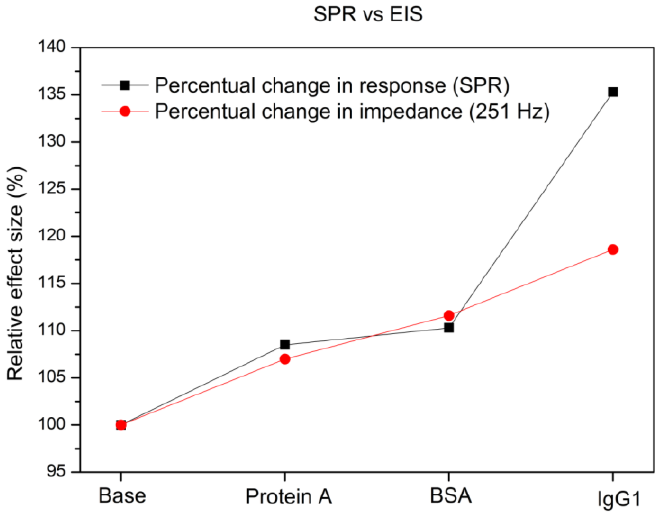
Figure 6. Relative effect sizes for EIS and SPR for each addition during the usability test. The effect sizes are normalized to their initial value and appear to be in the same order of